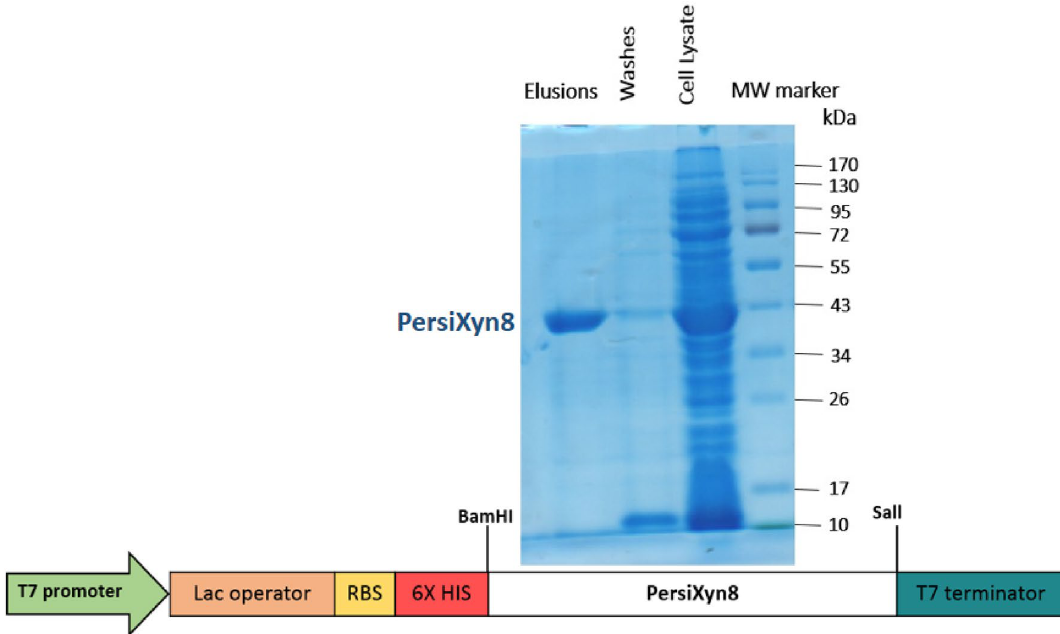
Figure 1. Schematic illustration map of the pET-28a ( +) expression vector used in this study and sodium dodecyl sulfate-PAGE (SDS-PAGE) of the purified PersiXyn8 is